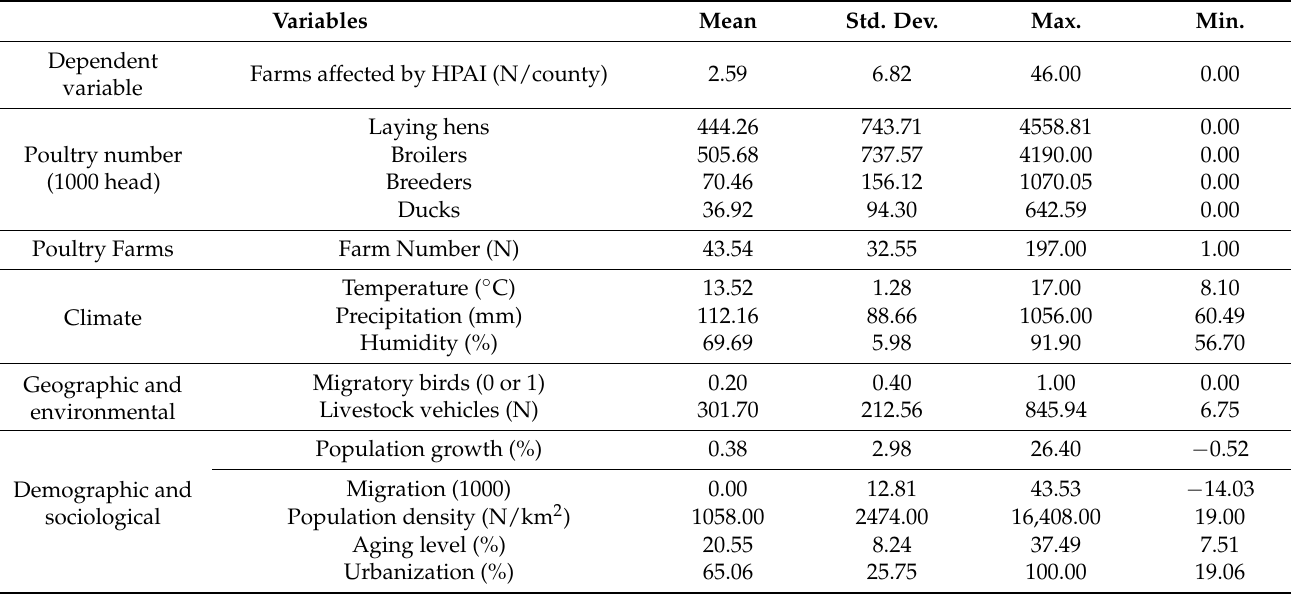
Table 1. Descriptive statistics (2016, N =